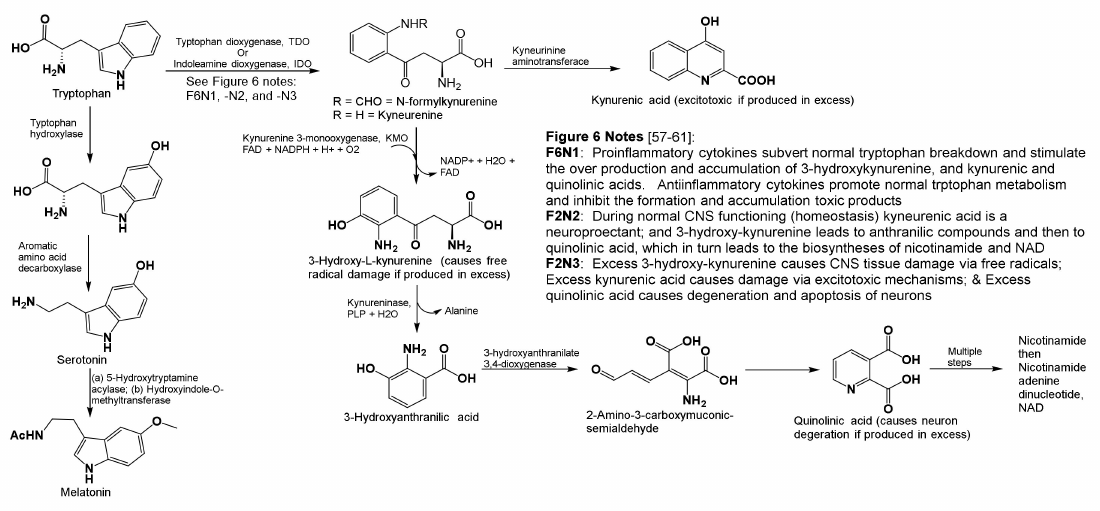
Figure 2. All tryptophan metabolites are normally produced in the CNS. In chronic stress (psychogenic or in diseases), proinflammatory cytokines help over-produce kynurenic acid, 3-hydroxykynurenine, and quinolinic acid, their excess accumulation in CNS causes oxidative damage, excitotoxicity, and neuron loss